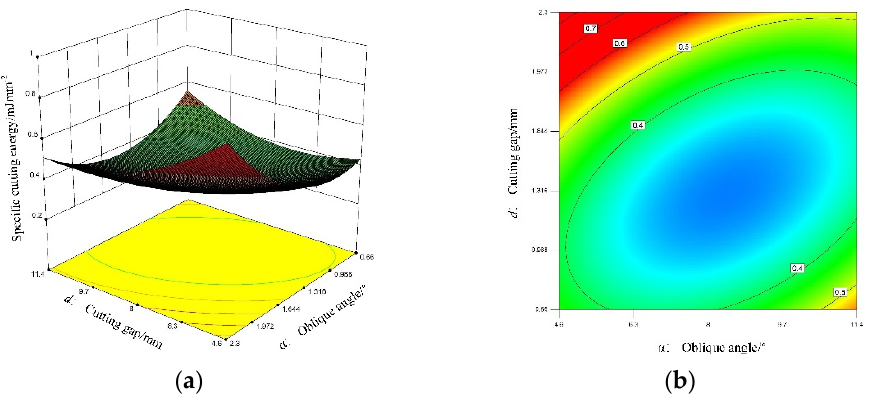
11 of 15 Figure 6. Effects of the sliding cutting angle and cutting gap on maximum cutting stress. ( a ) Re- sponse surface graph. ( b ) Contour map . It can be seen from Figure 7a that the interaction between the oblique angle and the cutting gap had a very significant effect on the cutting energy. The specific cutting energy first decreased and then increased with the increase in the oblique angle. When the oblique angle of cutting was 0~9°, as the oblique angle increased, the root fibers were more prone to being damaged by bevel cutting, and the cutting power consumption decreased at this time. However, when the oblique angle was greater than 9°, the cross-section of the root cutting increased, which led to an increase in the power consumption during the cut- ting process, and the specific cutting energy of the root cutting increased. Similarly, the specific cutting energy decreased first and then increased with the increase in the cutting gap, and reached the minimum value at about 1.3 mm. The reason was that the ratio of